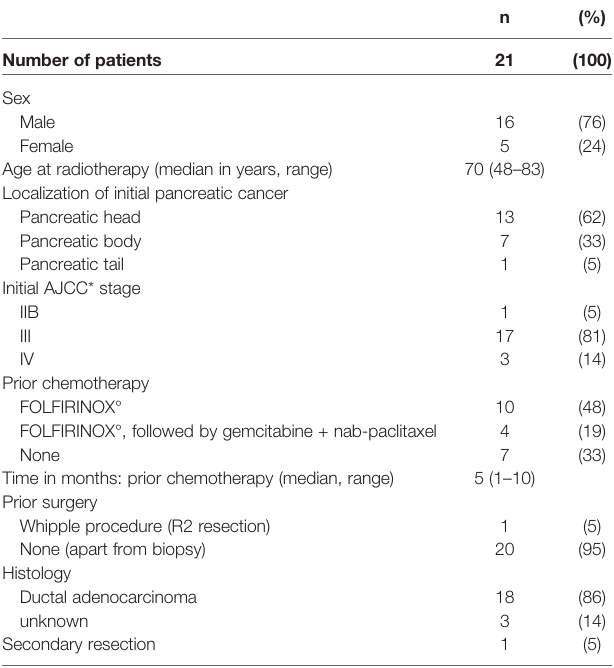
TABLE 1 | Patient characteristics.